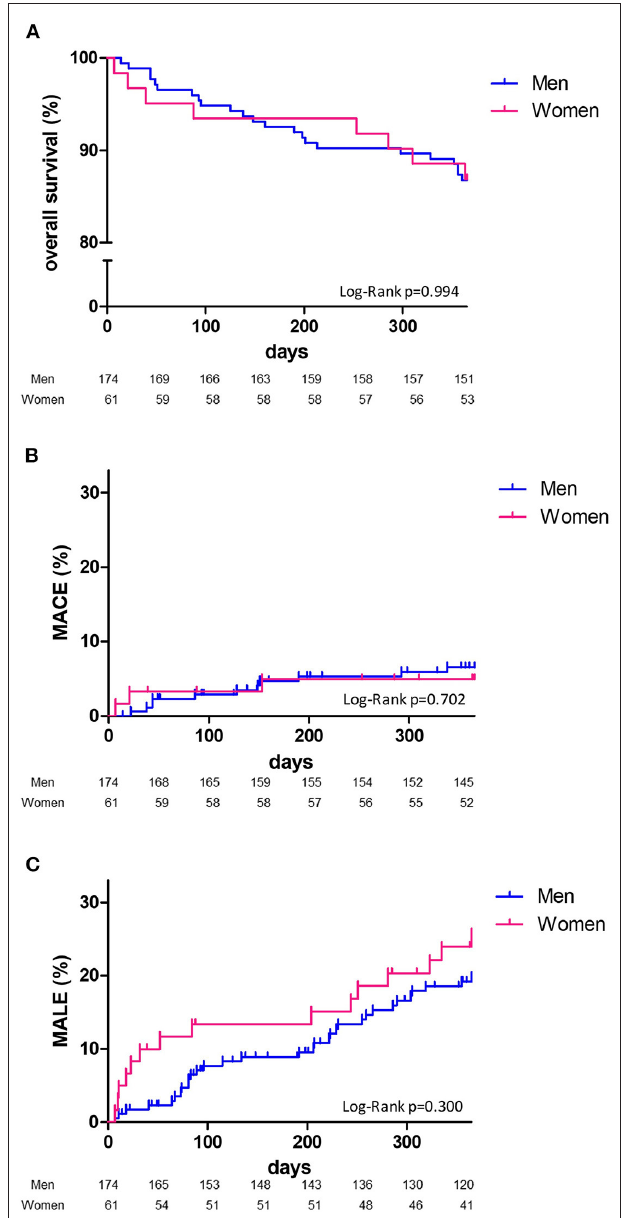
FIGURE 1 | One-year Kaplan-Meier survival curves. Overall survival (A) , major adverse cardiovascular events: MACE (B) , major adverse limb events: MALE (C) and comparison according to sex (men, blue line; women, red line) with Log Rank test comparisons between men (blue) and women